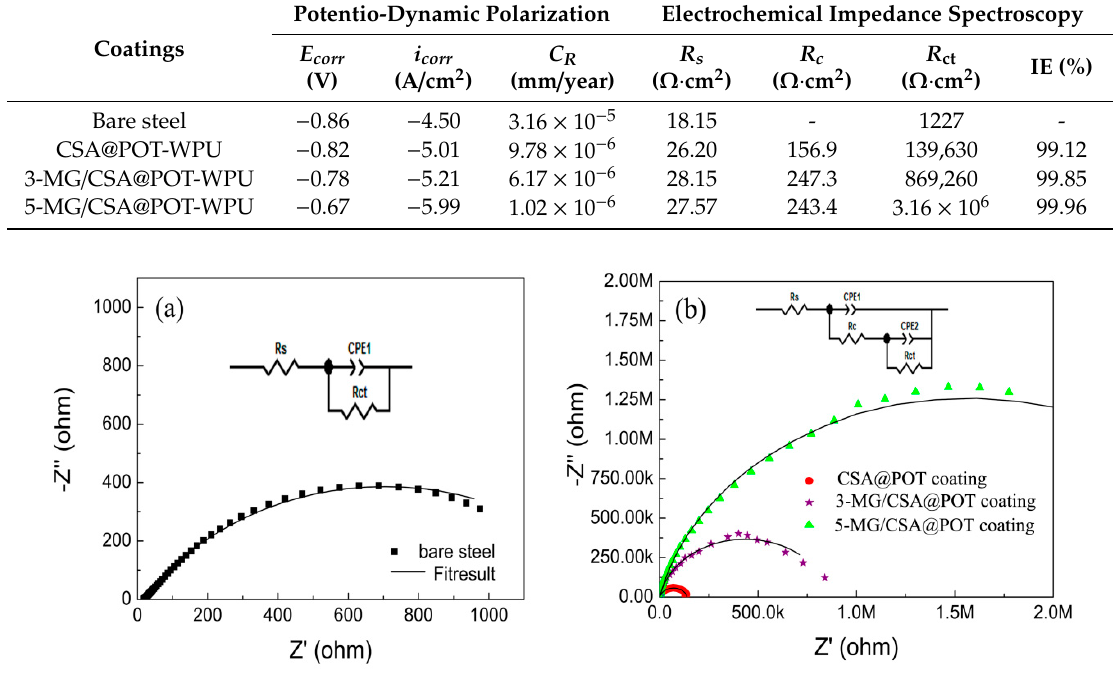
Figure 6. ( a ) EIS curves for the bare steel in a 3.5% NaCl solution. ( b ) EIS curves for CSA@POT coating, 3-MG/CSA@POT coating, and 5-MG/CSA@POT coating in a 3.5% NaCl solution. Table 1. Parameters for potentio-dynamic polarization and electrochemical impedance spectroscopy in a 3.5% NaCl solution.